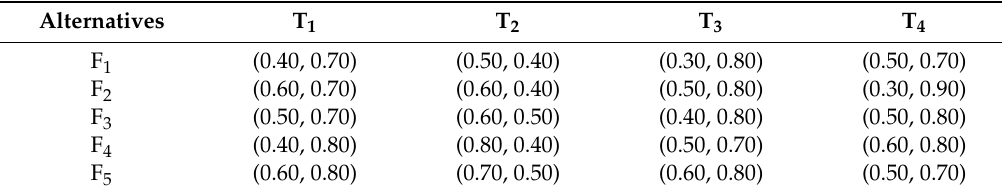
Table 6. Pythagorean fuzzy matrix by DM 1.